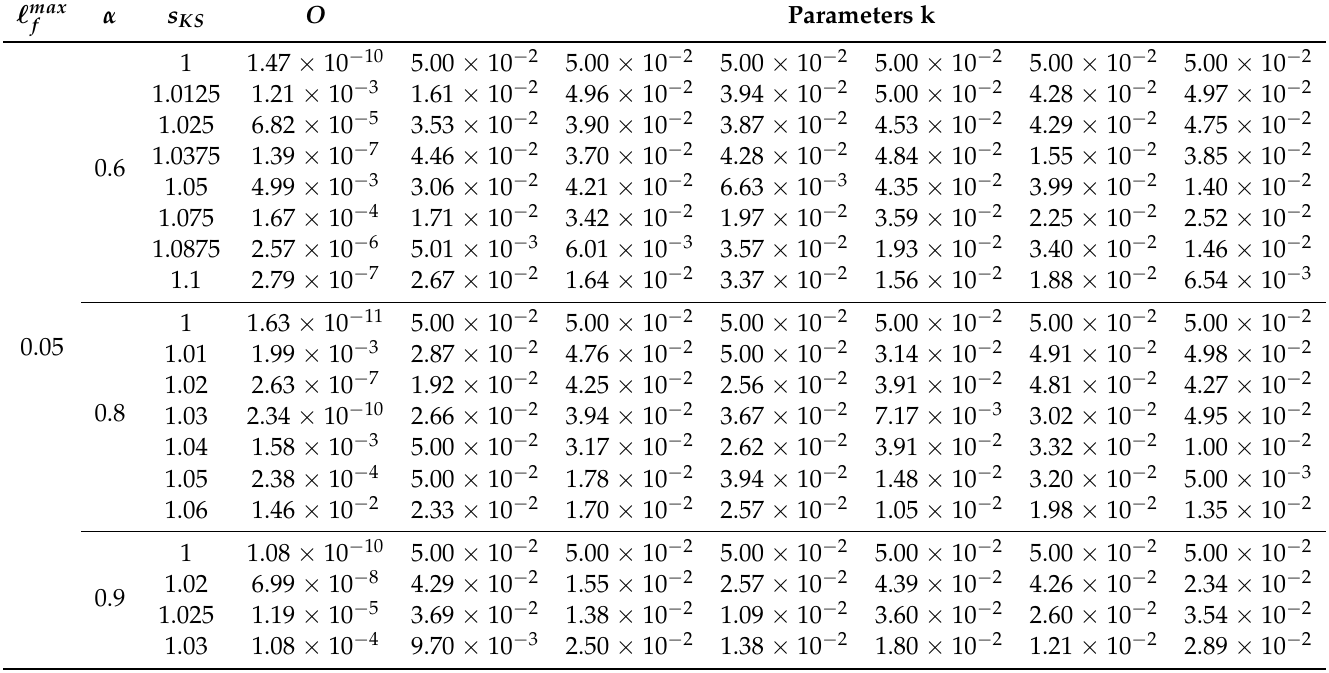
= 0.05 and α ∈ { 0.6,0.8,0.9 } f